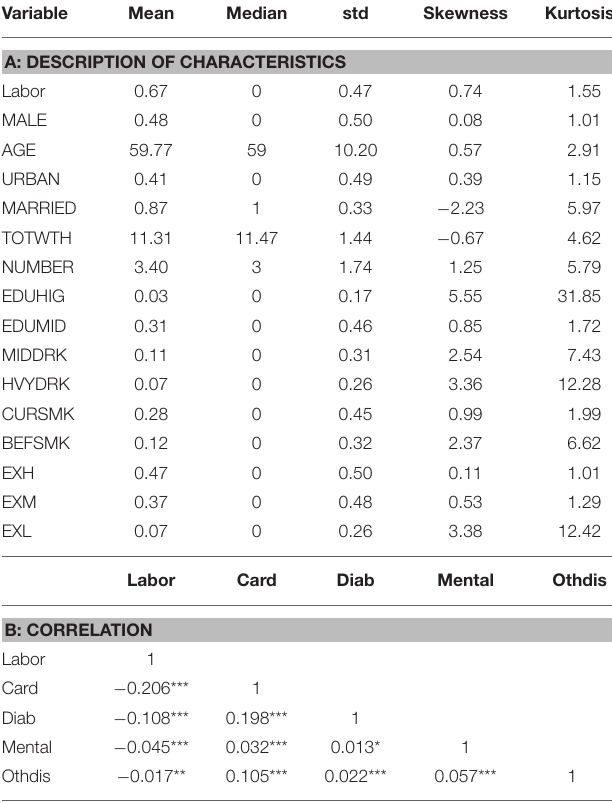
TABLE 1 | Summary description.